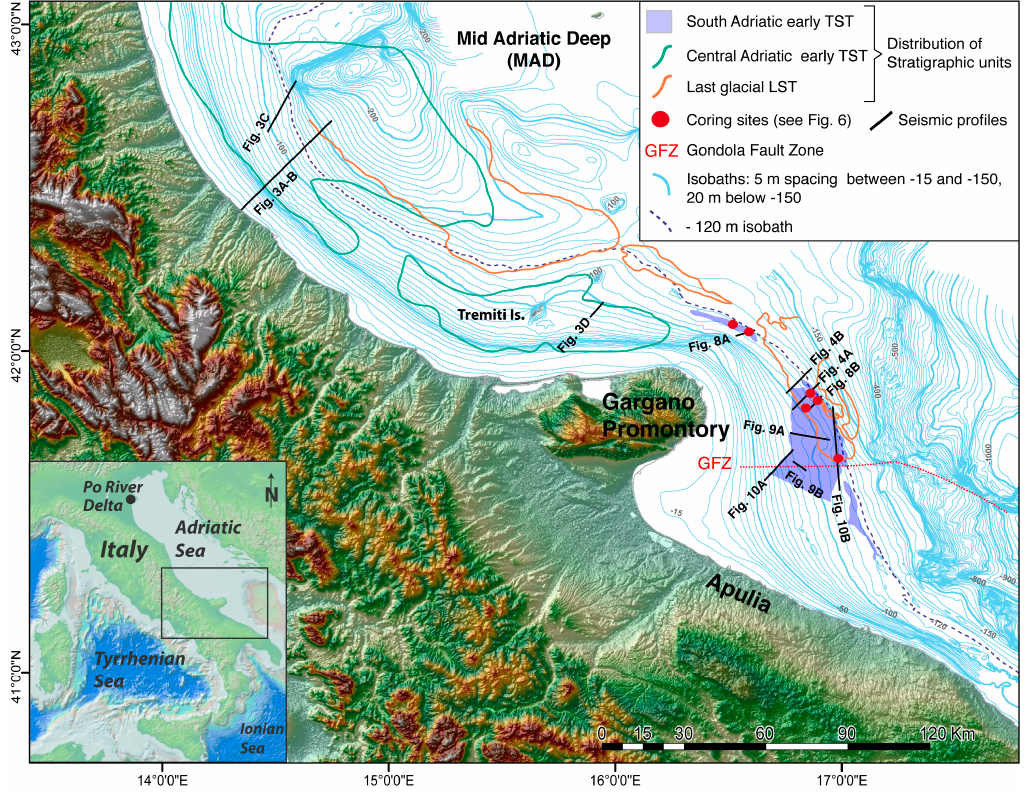
Figure 1. Study area and location of the South Adriatic early transgressive (TST) unit containing transgressive sand ridge deposits (the DTM is from NASA SRTM data). The distribution of early TST deposits in the Central Adriatic and of the last glacial lowstand (LST) are also shown, together with location of seismic profiles and core sites. Note the Gondola Fault Zone (GFZ) deforming the South Adriatic shelf and deeper basin. The abrupt termination of the area of distribution of the early TST, south of the GFZ, reflects the limitation of data available for this study.